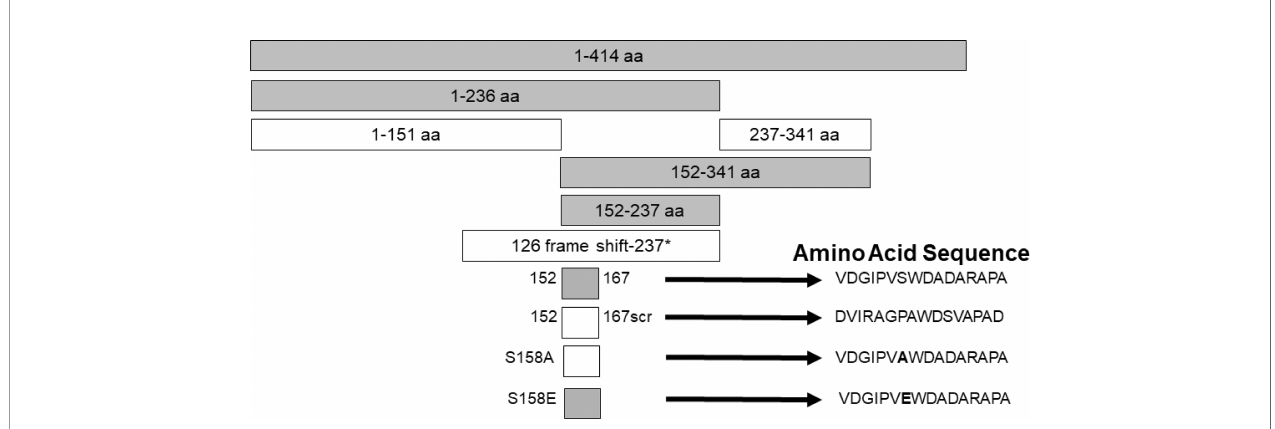
FIGURE 3 | Expression of HPgV NS5A peptides inhibits HIV replication, adapted from References (159, 162). Schematic representation of the region of NS5A protein stably expressed in CD4+ T cells. The regions that inhibited HIV replication are shaded. Full-length NS5A protein (414 amino acids) is shown on top, and deletion proteins below. The 16 aa peptide from 152 – 167 was suf fi cient to inhibit HIV replication. Scrambling the order of the 16 amino acids or mutating the putative phosphorylation site (serine) at amino acid 158 abolished HIV inhibition (scr), while mutating this to a glutamic acid (phosphomimetic) restored HIV inhibition functions. FS represents the full-length RNA for NS5A in which a frame shift insertion was created to abolish NS5A protein